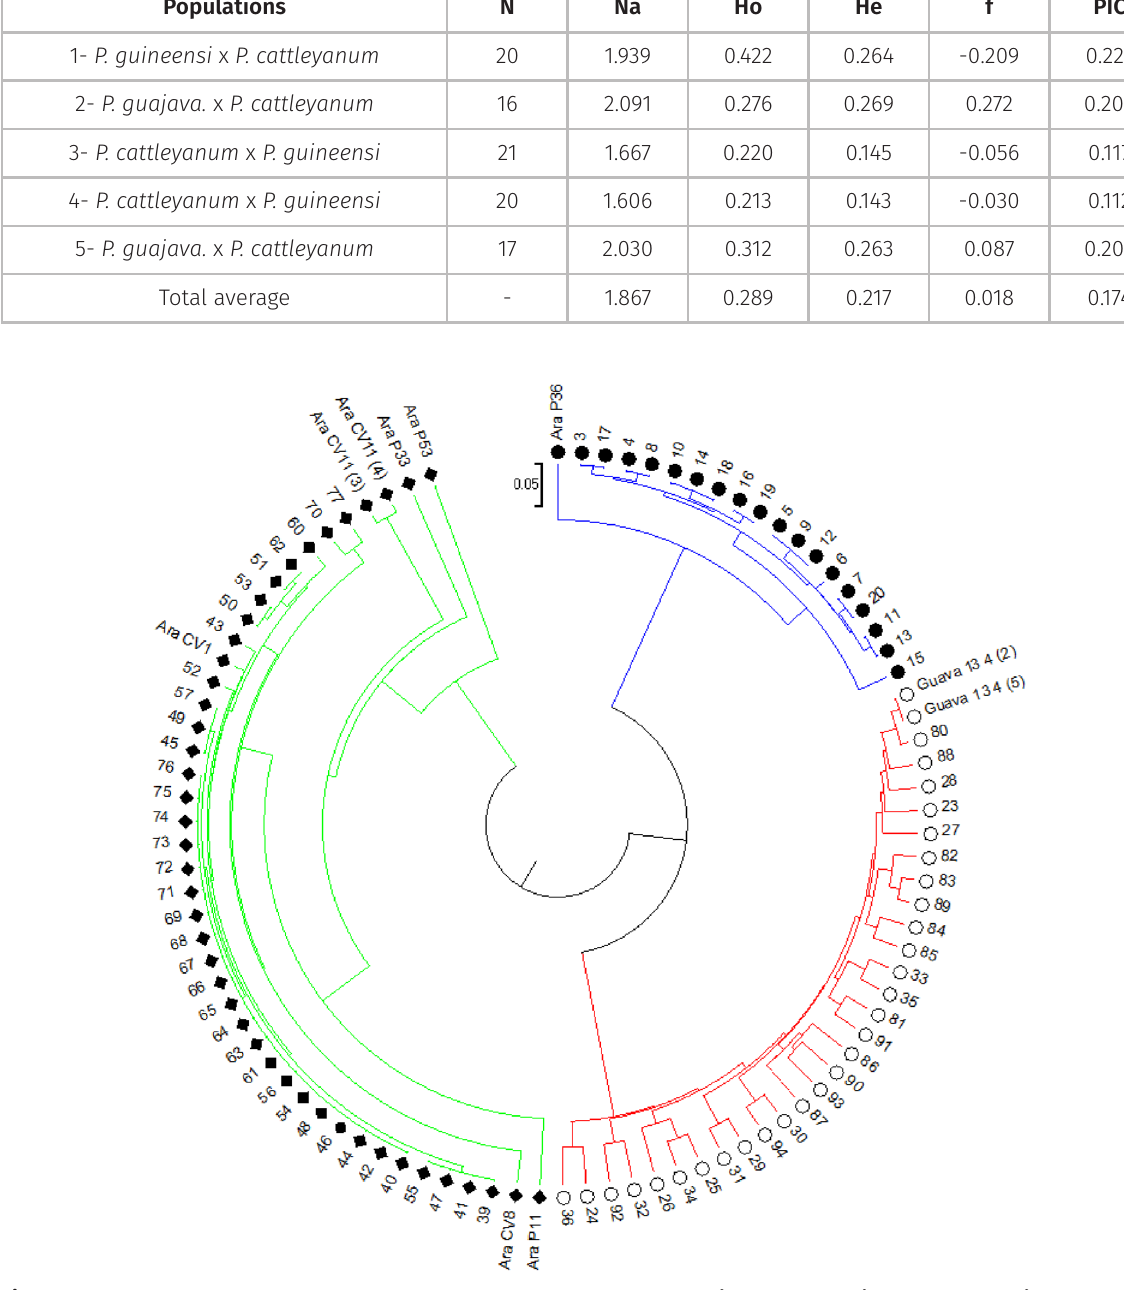
Figure 2. Dendrogram generated by the UPGMA method based on the distance established by the Weighted Index for 94 individuals originating from five populations obtained from interspecific crosses of Psidium spp. Blue group: formed by genitor Ara P36 and P. guineense (P36) × P. cattleyanum (P11) hybrids; red group: genitors Guava 13 4 (2), Guava 13 4 (5) and P. guajava (13.4II) × P. cattleyanum (P33) and P. guajava (13.4II) × P. cattleyanum (P51) hybrids; and green group: genitors Ara P11, Ara CV8, Ara CV1, Ara CV11 (3), CV11 (4), Ara P33 and Ara P53 and P. cattleyanum (CV8) × P. guineense (CV11) and P. cattleyanum (CV1) × P. guineense (CV11) hybrids. Cophenetic correlation =